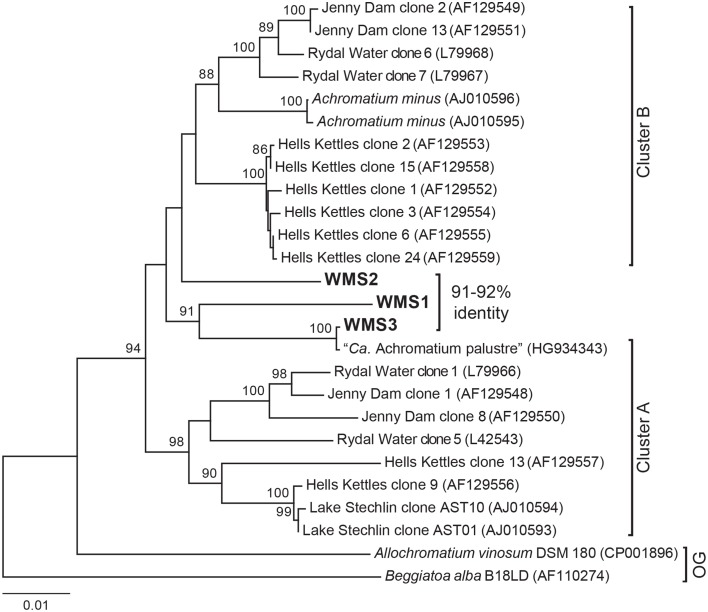
Maximum likelihood tree of 16S rRNA gene sequences of Achromatium populations with Allochromatium vinosum and Beggiatoa alba as outgroups (OG). NCBI accession numbers are given in parentheses. Sequences from the single cells analyzed in this study were obtained by PCR of the amplified gDNA (WMS1, WMS2, and WMS3) and are identical to the 16S rRNA gene sequences recovered from the assembled genomic data for each cell. The percent identity of the WMS Achromatium 16S rRNA sequences relative to one another are highlighted. Bootsrap values >85 based on 1000 samplings are given for each node.